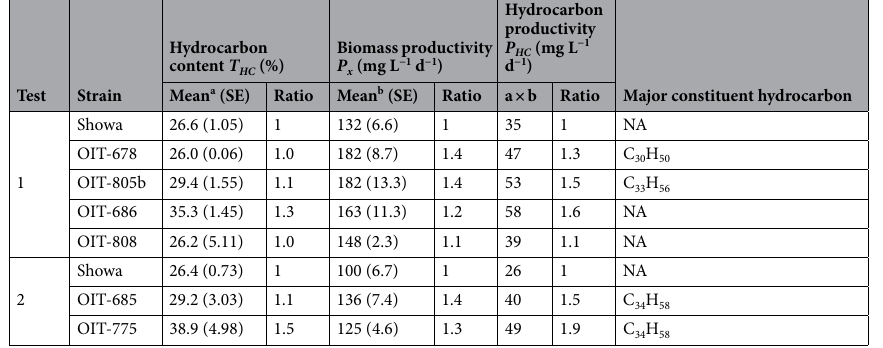
tivities (Table 4). The OIT-678 strain established a new record of D t = 1.23 days in B. braunii race B, where the previous record was 1.4 days of Showa 22 . The D t of OIT-678 falls short of the 1.11 days reported in the strain CCAP807/1, race A 27 , and the 0.52 days of an unknown strain 33 . The strain CCAP807/1 showed the D t of 1.11 days under a continuous light condition ( Php = 24:0, Table 4), which should be better than our culture con- dition ( Php = 14:10). In addition, although the race A and race B strains are classified as the same species, their